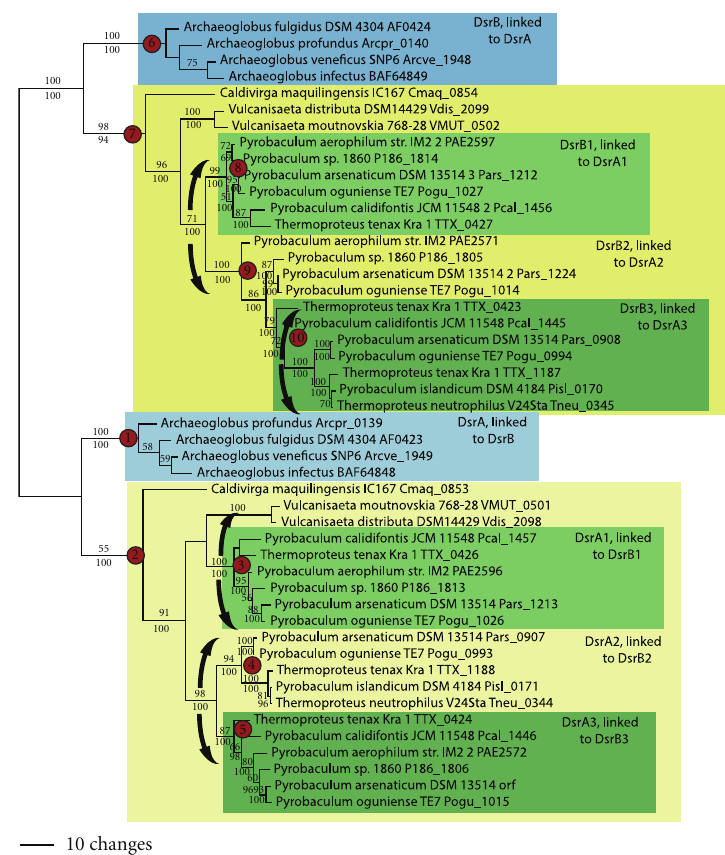
Figure 6: Dissimilatory sulfite reduction. Phylogenetic tree for DsrA and